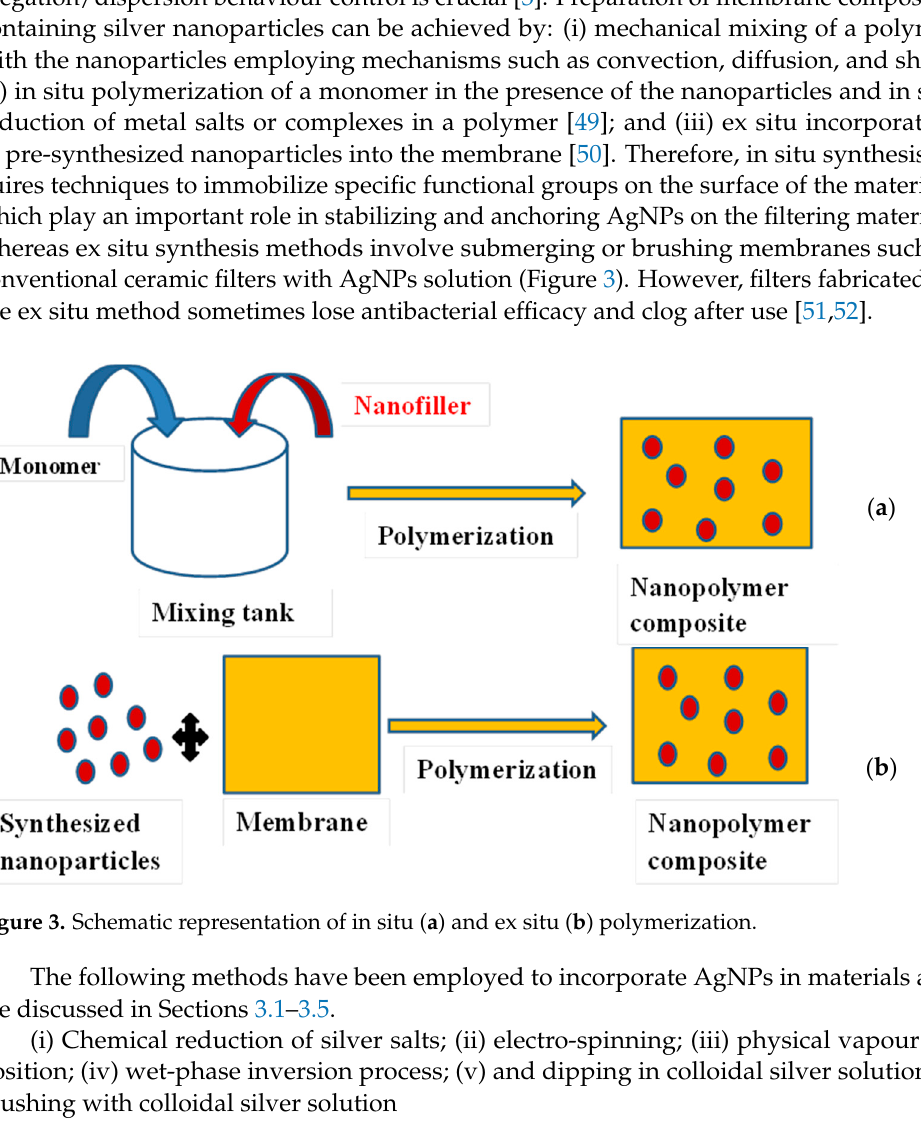
Figure 2. Synthesis methods for silver nanoparticles.